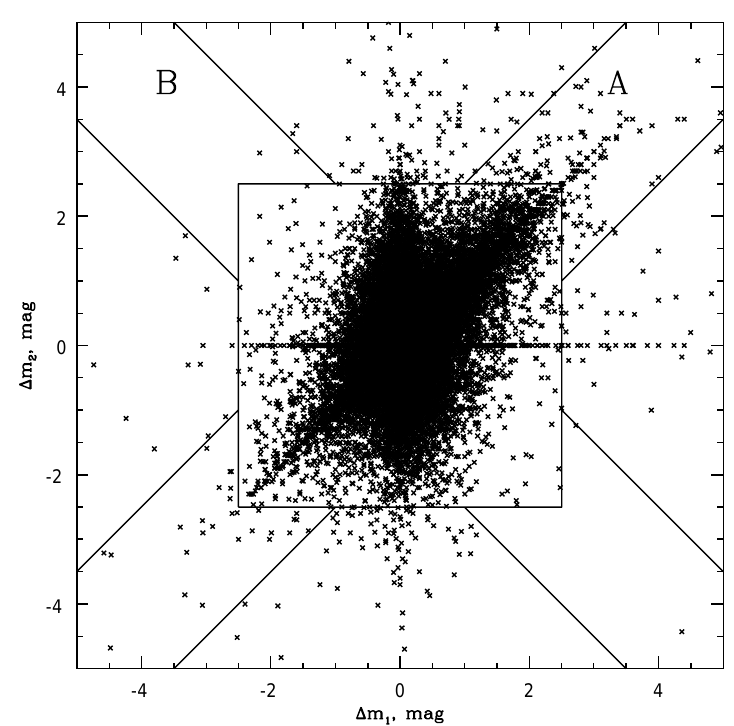
Fig. 1. The distribution of the matched WDS-CCDM pairs on the ∆ m 1 vs. ∆ m 2 plane. The central square region indicates the approximate area of trouble-free identifica- tions. Band A indicates pairs where the two catalogues most likely provide magnitudes in different photometric systems. Band B indicates pairs where the reference and concerned components may be selected differently in different